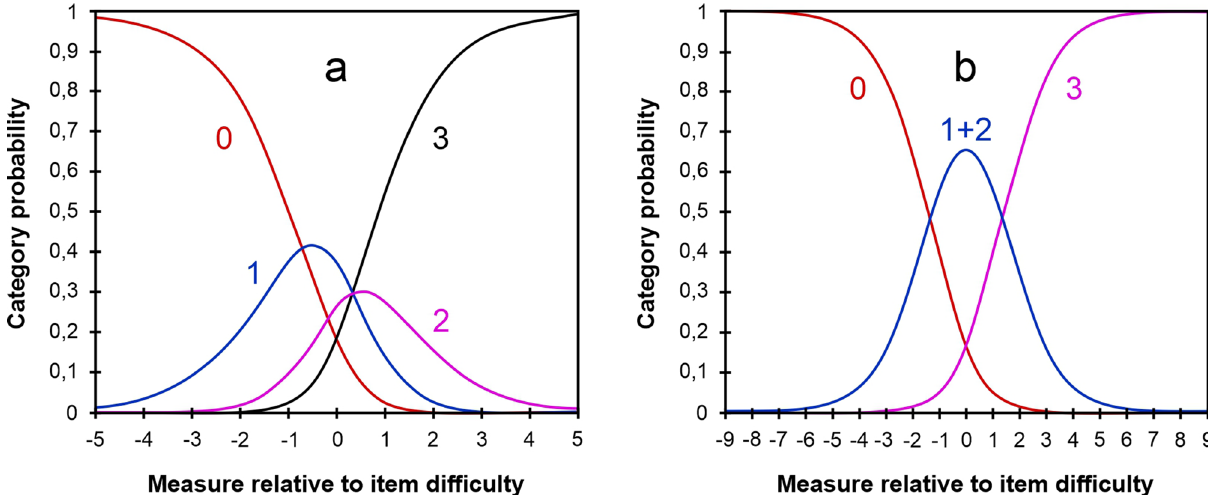
Figure 1. ( a ) Shows the category probability curves (CPC) for the instrument with 33 items and four response categories. Each curve in the CPC graph represents one response category (No = 0; Occasionally = 1; Often = 2; Almost always = 3). The point where two adjacent curves overlap is the threshold. At this intersection, it is the same likelihood of choosing one category or another. ( b ) CPC for the instrument with 33 items collapsing the categories 1 (Occasionally) and 2